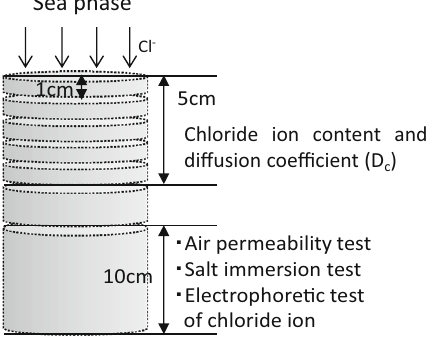
Fig. 2 Exposed concrete